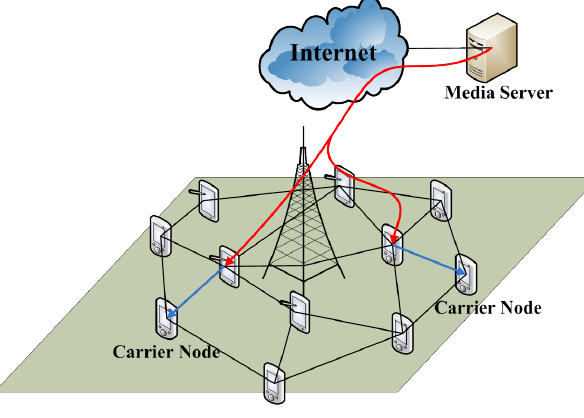
Figure 1: The architecture of PSIM